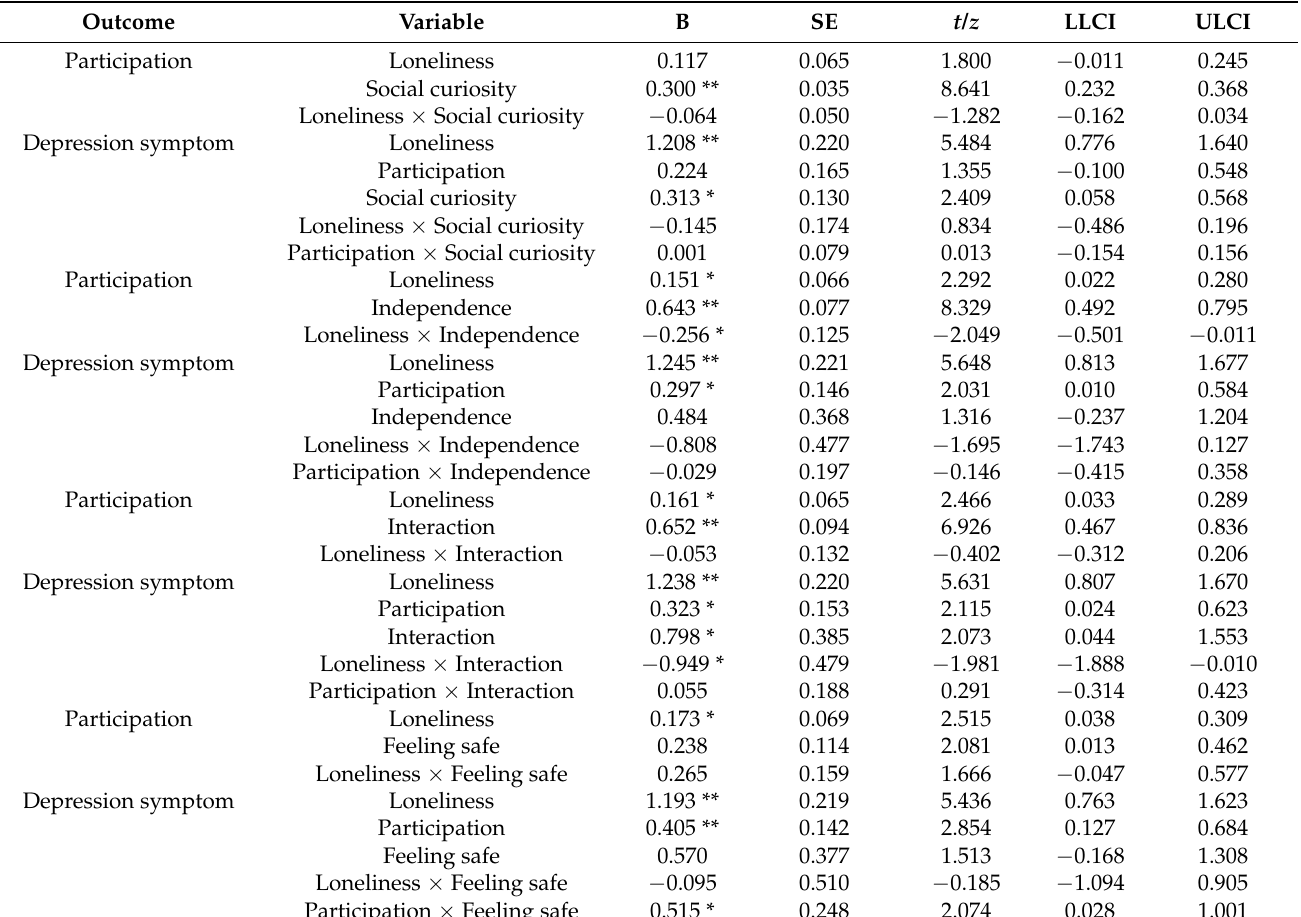
Table 5. Moderated mediation analysis (social curiosity, interaction, participation, and feeling safe as moderators).